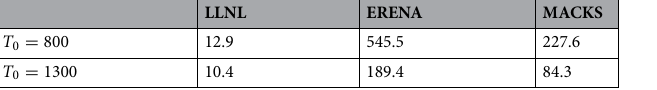
Table 2. Efficient ratios of LLNL, ERENA ,and MACKS for the nC 7 H 16 /air mixtures where h = 1 × 10 − 8 , p 0 = 2.0MPa , and T 0 = 800 and 1300 K.